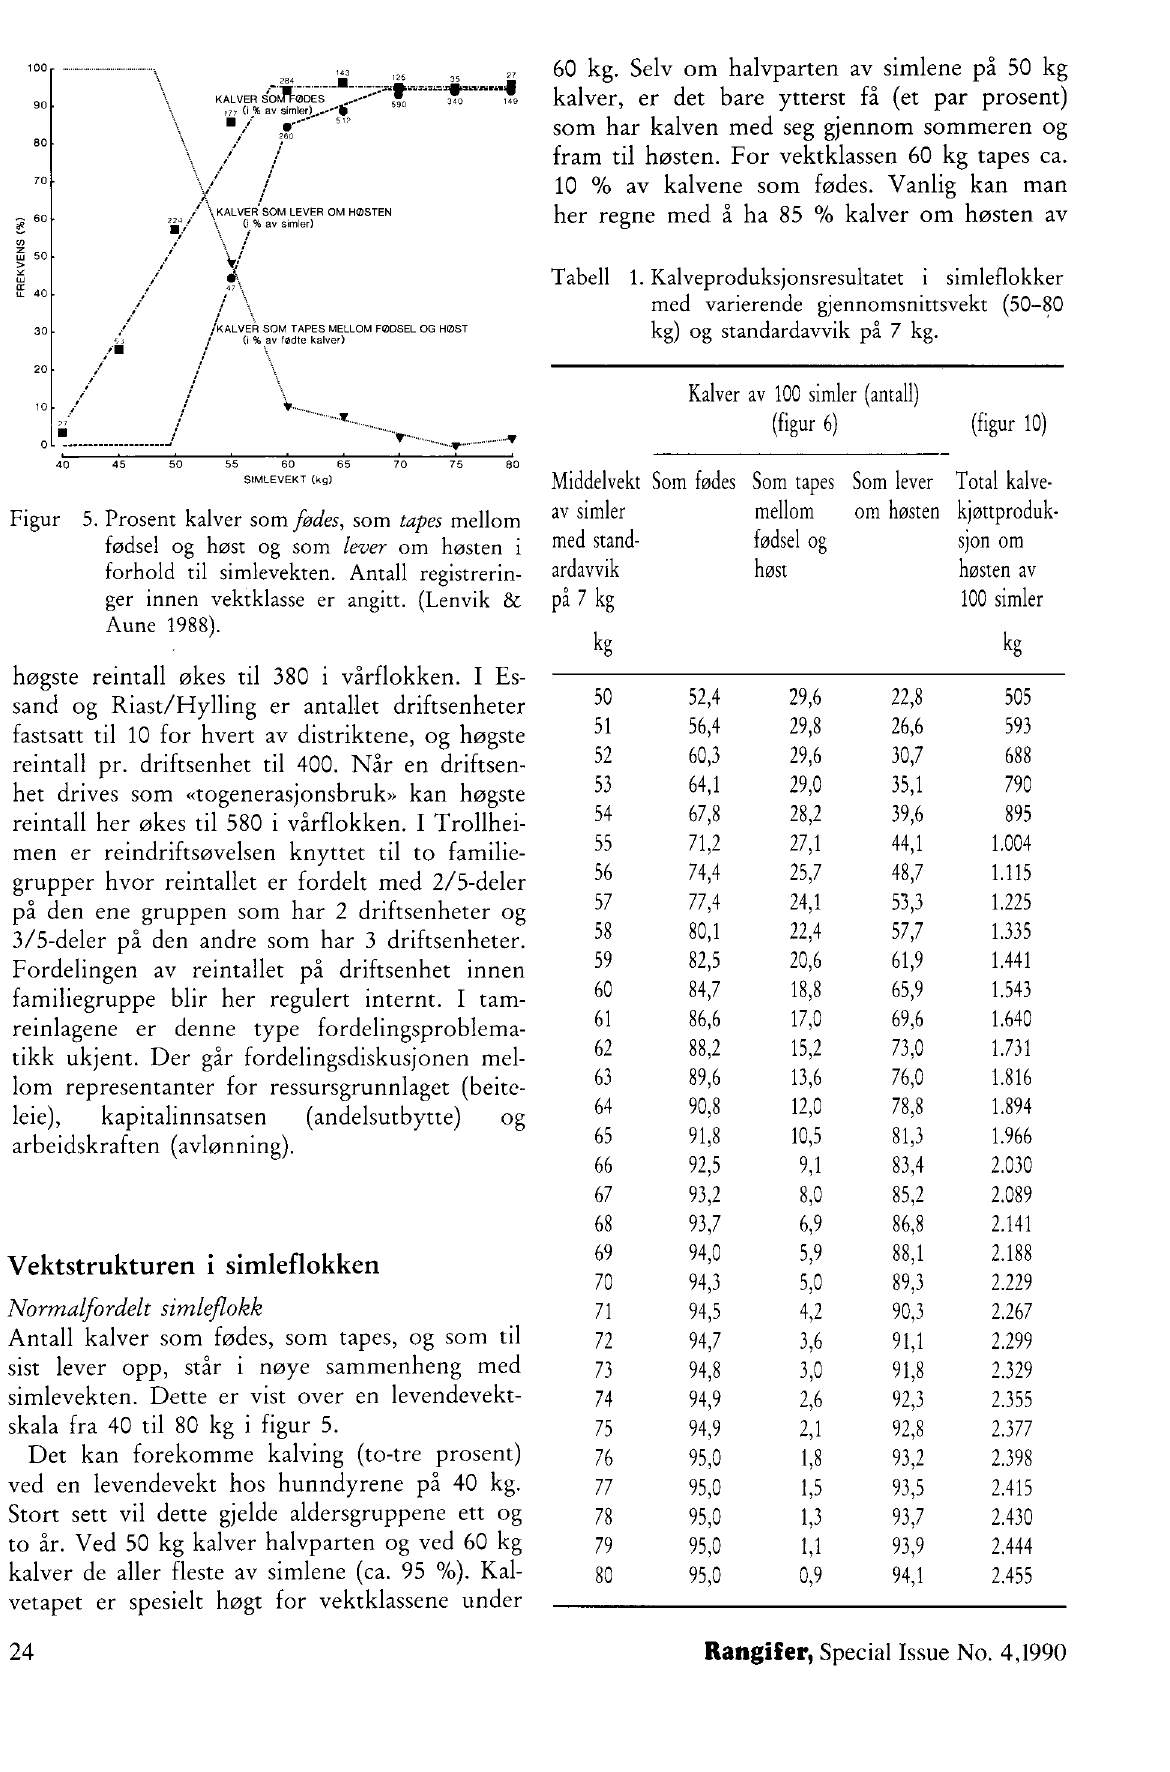
Figur 5. Prosent kalver som fødes, som tapes mellom fødsel og høst og som lever om høsten i forhold til simlevekten. Antall registrerin